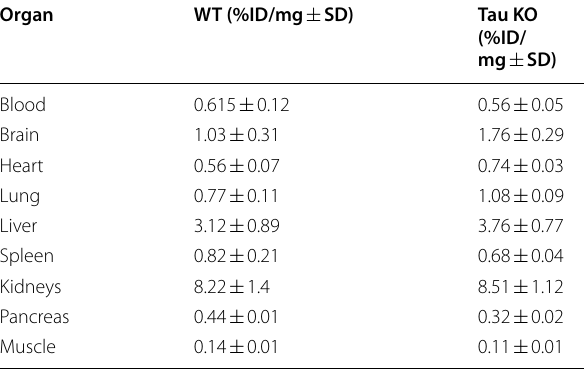
Table 1 Post-PET biodistribution results from wild type (WT) and tau knockout (KO) mice ( n 6/group) with % injected dose = (ID)/mg of tissue standard deviation (SD) after IV injection ±